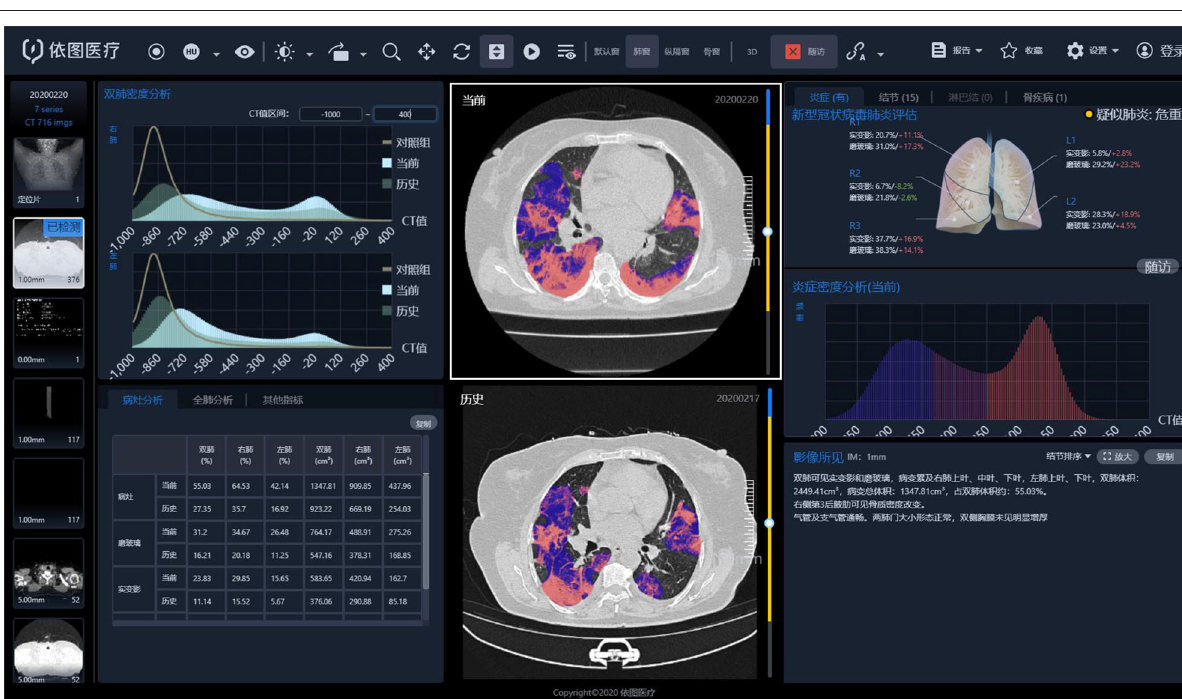
FIGURE 3 | CT image quantization and analysis with artificial intelligence